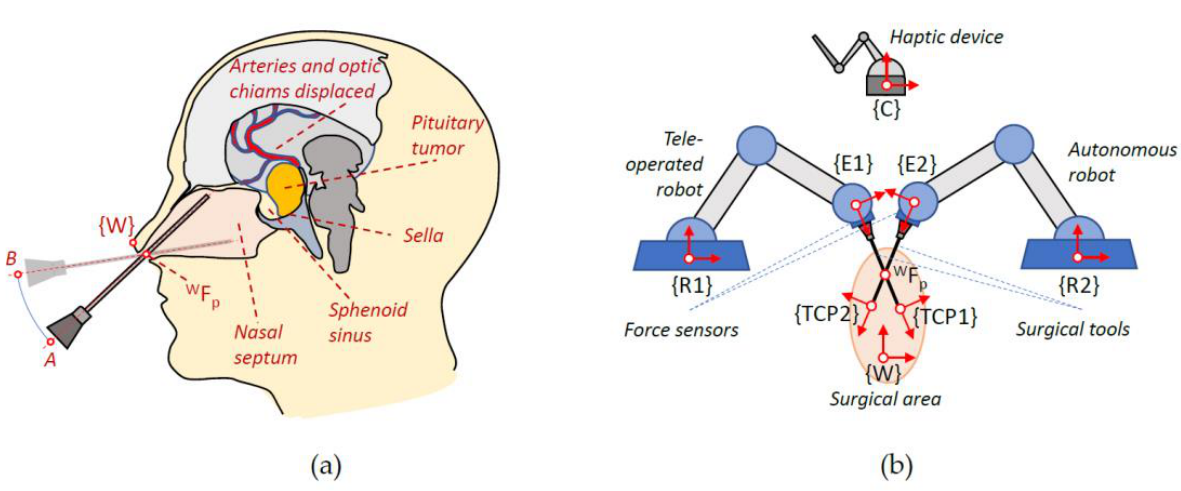
Figure 1. Surgical scenery. ( a ) Movement of the instruments inside the nasal septum. ( b ) Robotic assistant and reference frames.